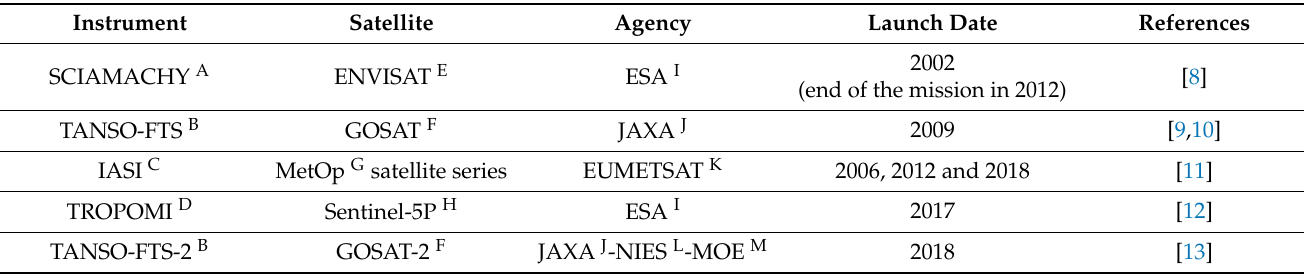
Table 1. Satellite missions providing methane concentration in the atmosphere since